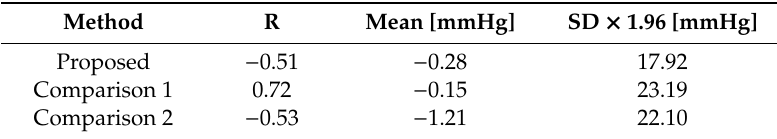
Table 1. Statistics of the Bland–Altman